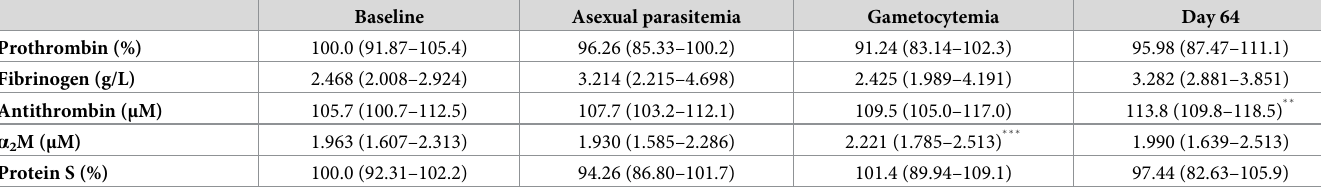
Table 2. Levels of pro- and anticoagulants in the four stages of plasmodium falciparum infection.